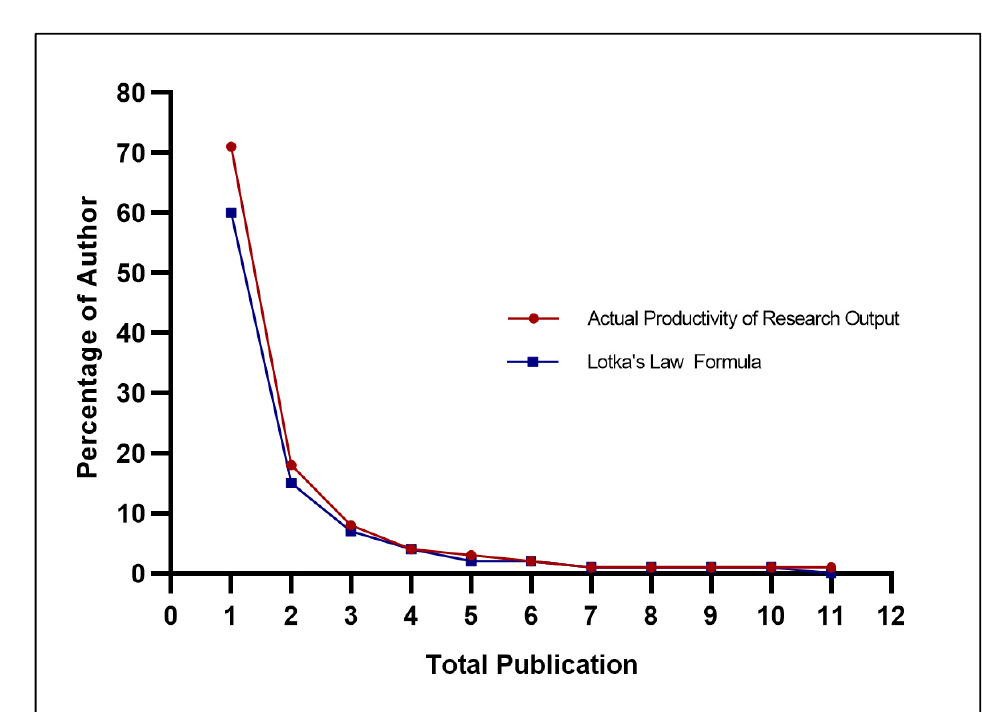
Figure 8. Percentage of authors publishing a certain number of diabetes-related papers in Malaysia compared with Lotka’s law.